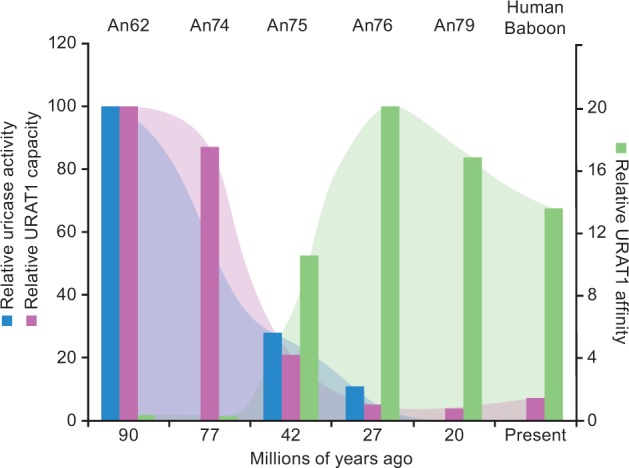
Gain of high uric acid affinity for URAT1 occurred at the same time in evolution as loss of uricase activity. Data for uricase activity were adapted from Kratzer et al. (2014) where the catalytic efficiency (Kcat/Km) of uricase ancestor An19/22 (7.08 × 105) from approximately 90 Ma was set to 100%. The catalytic efficiencies of other ancestral uricases are expressed as a percentage of the activity of An19/22. Uric acid affinity and transport capacity of URAT1 are from table 1 where, for An62, the Km (1,360 µM) was set to 1.0 and the Tmax (2,324 pmol/min) was set to 100. The affinity and transport capacity of the other URAT1 transporters were expressed as the ratio relative to An62.